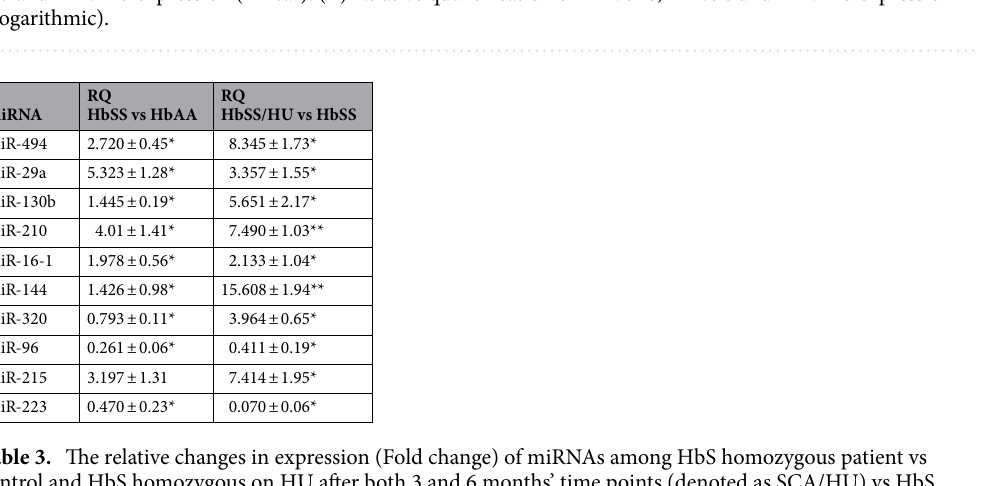
Figure 2. Expression of miRNAs in controls and SCD patients before and after hydroxyurea treatment. ( A ) Relative quantification of miR-494, miR-29a, miR-130b, miR-210, miR-16-1, miR-144, miR-320, miR-96, miR- 215 and miR-223 expression (Linear). ( B ) Relative quantification of miR-320, miR-96 and miR-223 expression (Logarithmic).